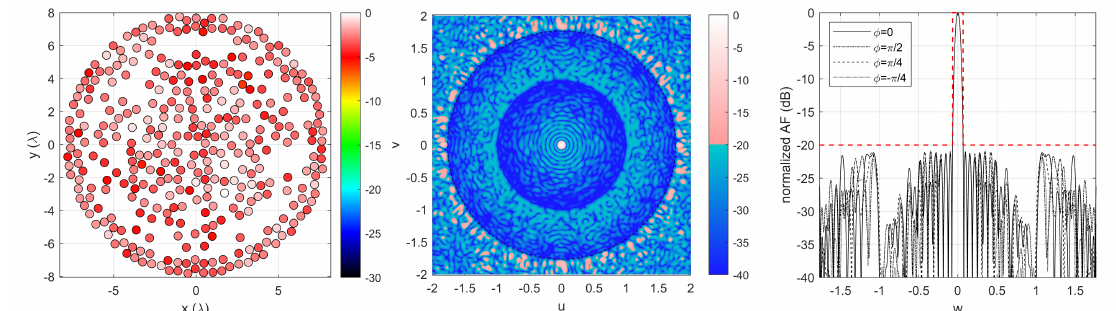
Figure 8. The 346 elements sparse layout. Left subplot: position and normalized excitation amplitude (dB) of the synthesized layout; center subplot: normalized Array Factor in the uv plane; right subplot: some relevant cuts. Negative values of w are related to the cuts φ (cid:48) = φ + π